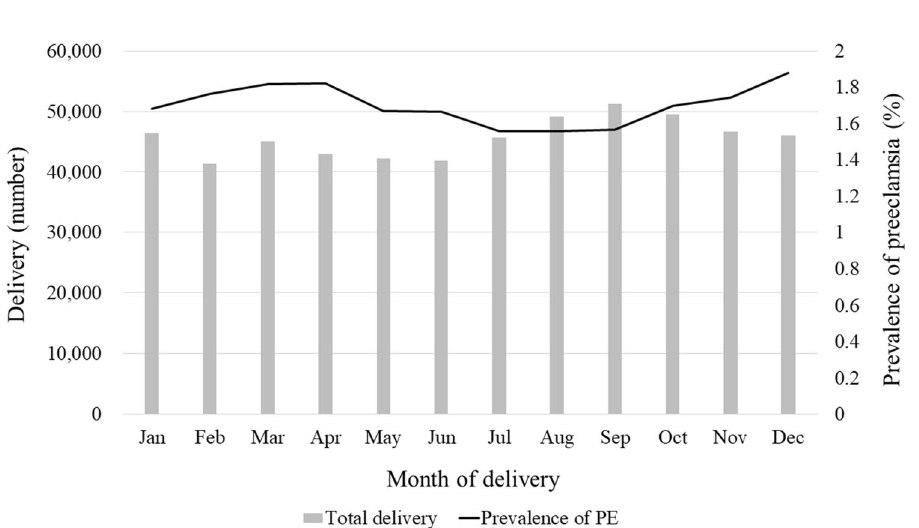
Figure 2. Prevalence of preeclampsia according to the month of